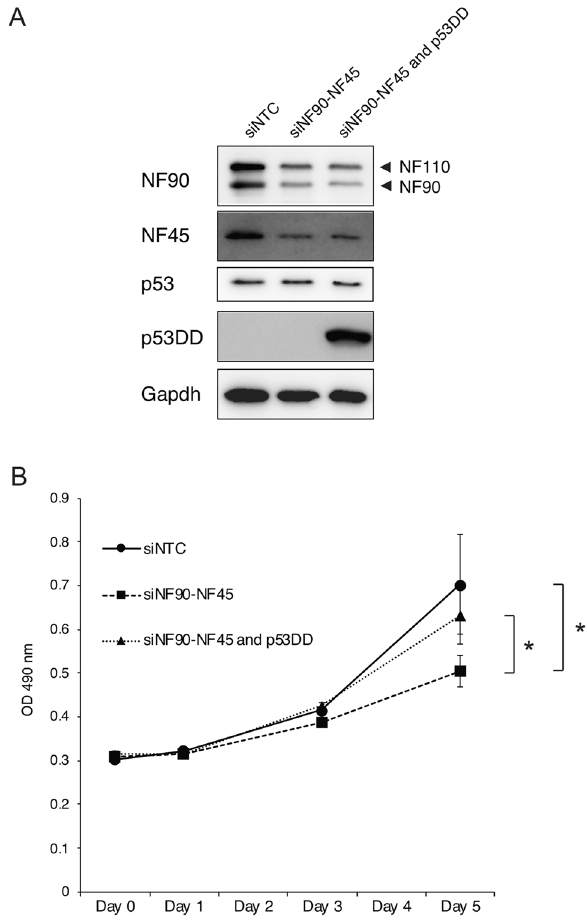
Figure 6. Dominant negative form of p53 (p53DD) recovers the growth retardation by the knockdown of NF90–NF45 in β cell lines. ( A ) BTC6 cells were co-transfected with the indicated siRNA with or without p53DD expression vector. Expression level of NF90, NF45, Gapdh, p53 and p53DD were detected by western blot. Gapdh was used as an internal control. ( B ) Proliferation of BTC6 cells co-transfected with indicated siRNA with or without p53DD expression vector were analyzed by MTS assay. Data were expressed as mean ± standard deviations. (n = 3 per group). *P < 0.05 relative to either siNTC or siNF90–NF45 and p53DD-treated cells by a two-tailed Student’s t